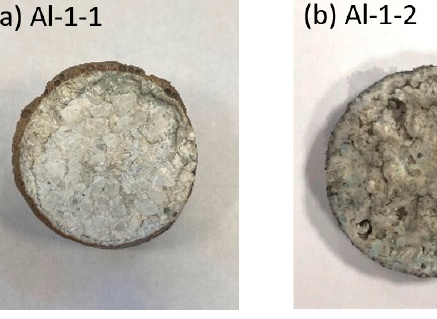
Figure 9. The alumina-spinel refractory after corrosion by slag R ( a ) Al-1-1 (1350 °C) and ( b ) Al-2-1 (1450 °C), and slag S ( c ) Al-2-1 (1350 °C) and ( d ) Al-2-2 (1450 °C).